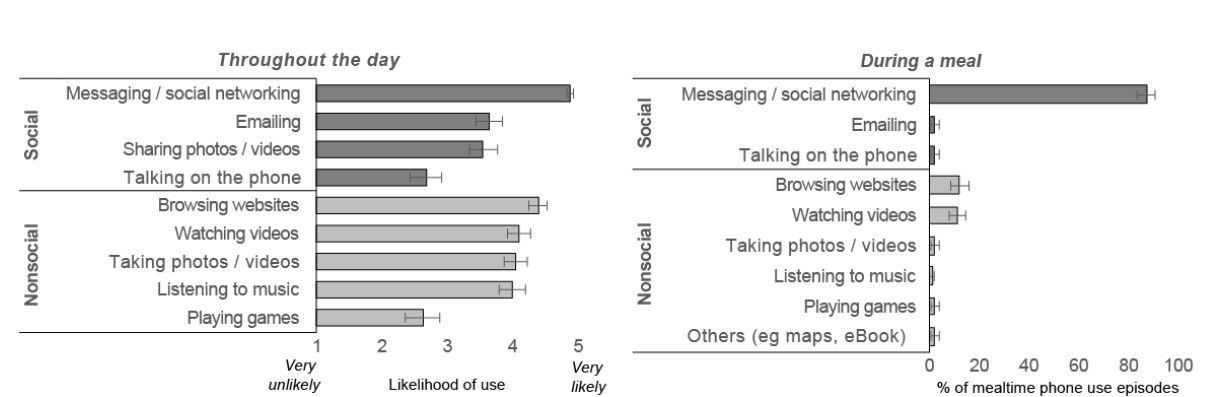
Figure 2. (Left) In a baseline questionnaire on habitual phone use, participants reported how likely they were to use each phone function on a regular day. A higher score corresponds to greater likelihood, and horizontal lines represent the 95% CI for the mean. (Right) Participants were then monitored closely for 1 week; the graph on the right depicts the percent of mealtime phone use episodes where each phone activity was recorded. Horizontal lines represent the 95% CI for each